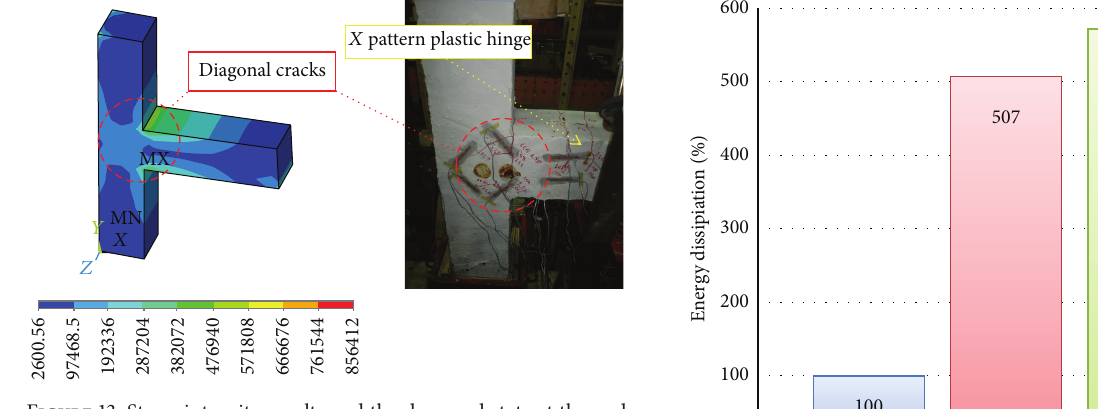
Figure 13: Stress intensity results and the damaged state at the end of seismic test for the DCL-SINGLE specimen.